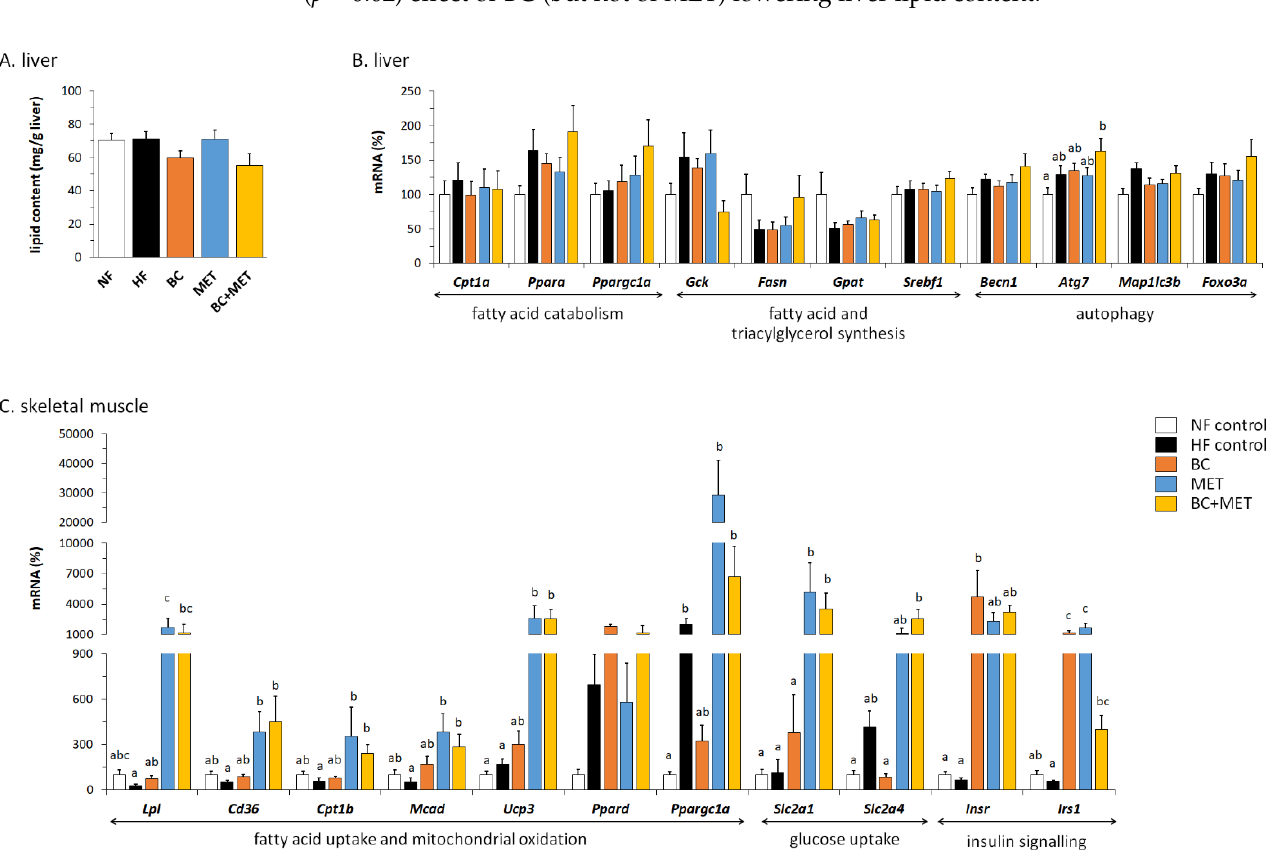
Figure 6. Liver total lipid content ( A ), mRNA levels of the indicated genes in liver ( B ) and skeletal muscle ( C ) at the end of the experiment. Obesity-prone mice were challenged with a high-fat diet for 4 weeks while receiving placebo (HF control) or being treated orally with BC (3 mg/kg/day), MET (100 mg/kg/day), or their combination (BC+MET); a fifth group received placebo and was kept on a normal-fat diet (NF control). Data are means ± SEM of five to nine animals per group, and mRNA levels are expressed relative to the mean value of the NF control group, which was set to 100. To compare between groups, one-way ANOVA followed by Tukey’s Honest Significant Difference post hoc test was